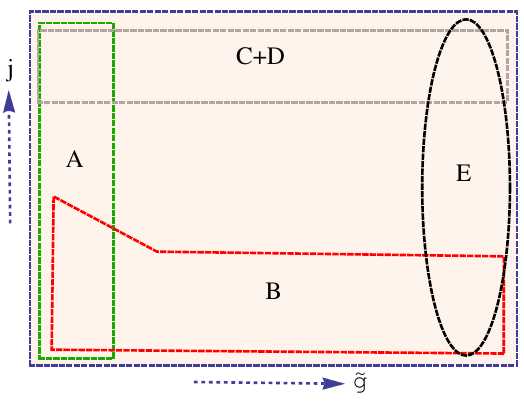
Figure 1. A visualisation of the data in the ~ g - j plane as presented